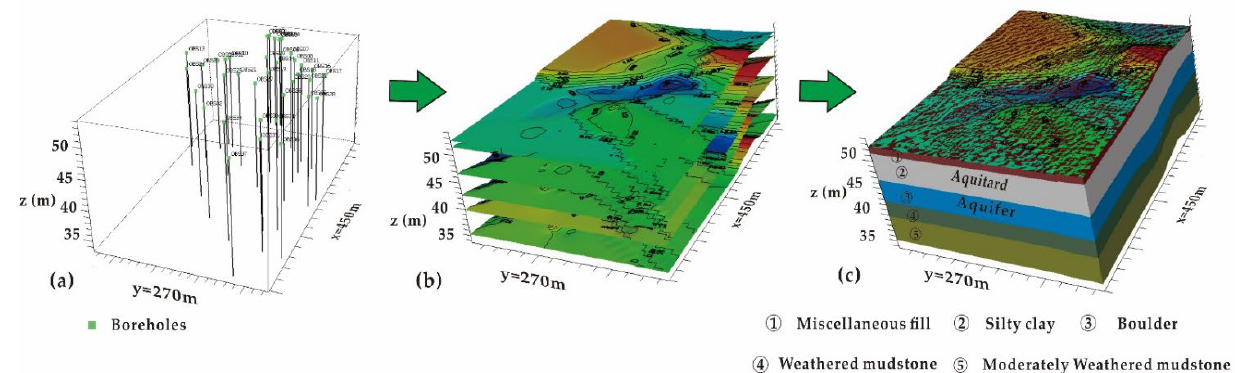
Figure 2. Conceptual modeling design: ( a ) borehole and cross-sections elevation point; ( b ) surface obtained from interpolation of the point data; ( c ) Solid geostratigraphical model obtained from the surface (z exaggeration = 10